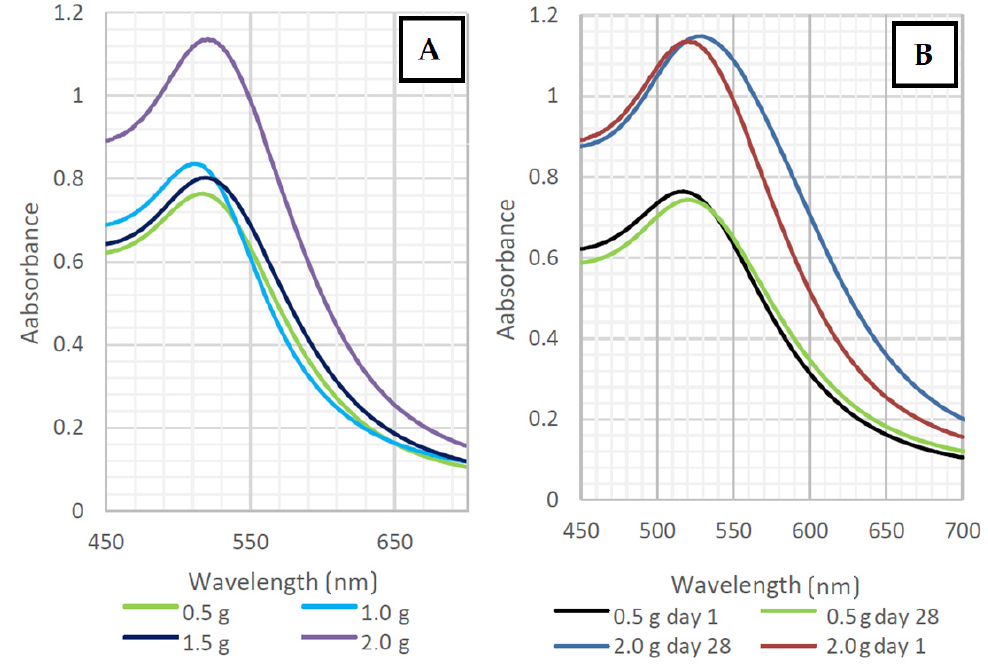
Figure 2. ( A ) Changes in the absorbances of AuNPs in PEG/TCD/H 2 O with different TCD/H 2 O ratios (0.5 g/100 mL, 1.0 g/100 mL, 1.5 g/100 mL, and 2.0 g/100 mL) prepared with a deposition time of 300 s; ( B ) changes in the AuNPs’ absorbances in PEG/TCD/H 2 O with different TCD/H 2 O ratios (0.5 g/100 mL and 2.0 g/100 mL) prepared with a deposition time of 300 s during the aging process.